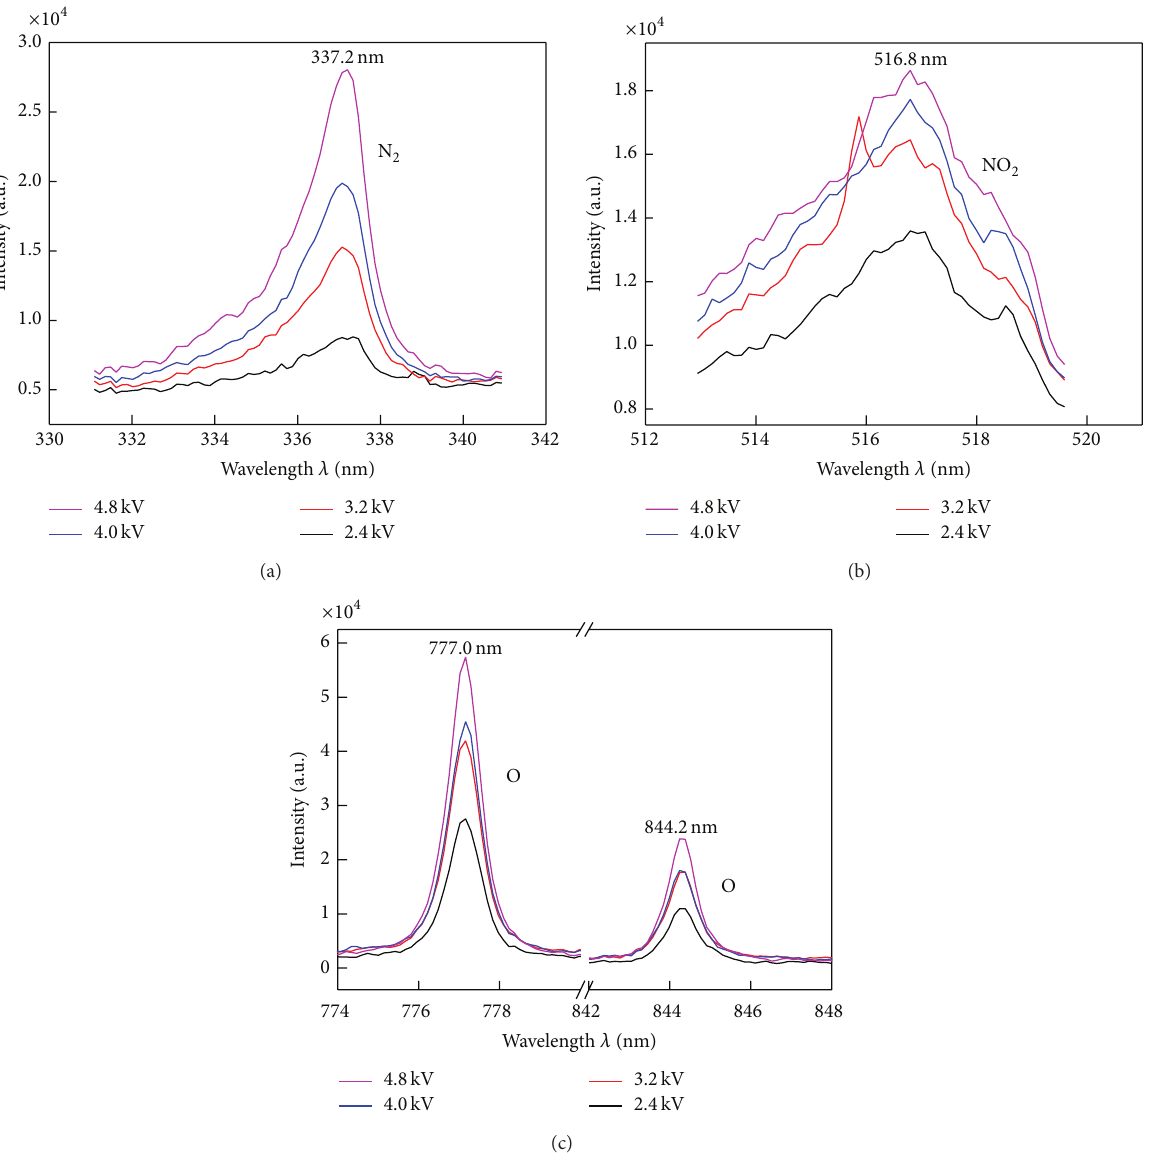
Figure 5: The characteristic spectra under different pulse voltage, identified at (a) 337.2 nm of N 2 molecule, (b) 516.8 nm of NO 2 molecule, and (c) 777.0nm and 844.2 nm of O